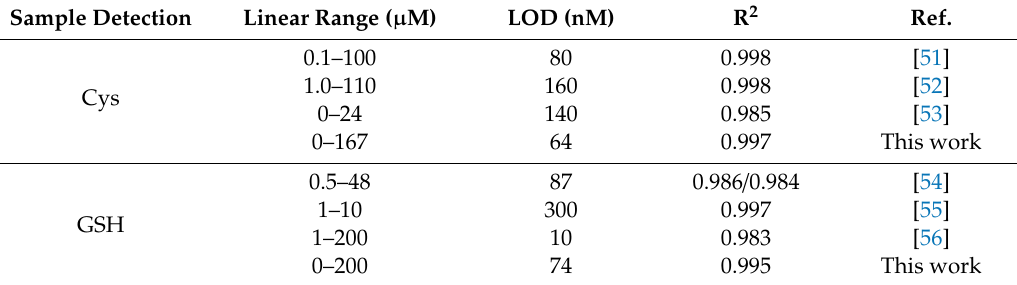
Figure 7. ( a ) The fluorescence spectra of C/N-dots with different concentration of Cys. The insets in (a) illustrate FL intensity against concentration of Cys. The RLS spectra in the presence of different concentration of Cys ( b ) and GSH ( c ) respectively. The insets in ( b ) and ( c ) illustrate FL intensity of scattering peak against concentration Cys of and GSH, respectively. Table 1. Comparison of recently reported fluorescent CDs for detection of Cys and